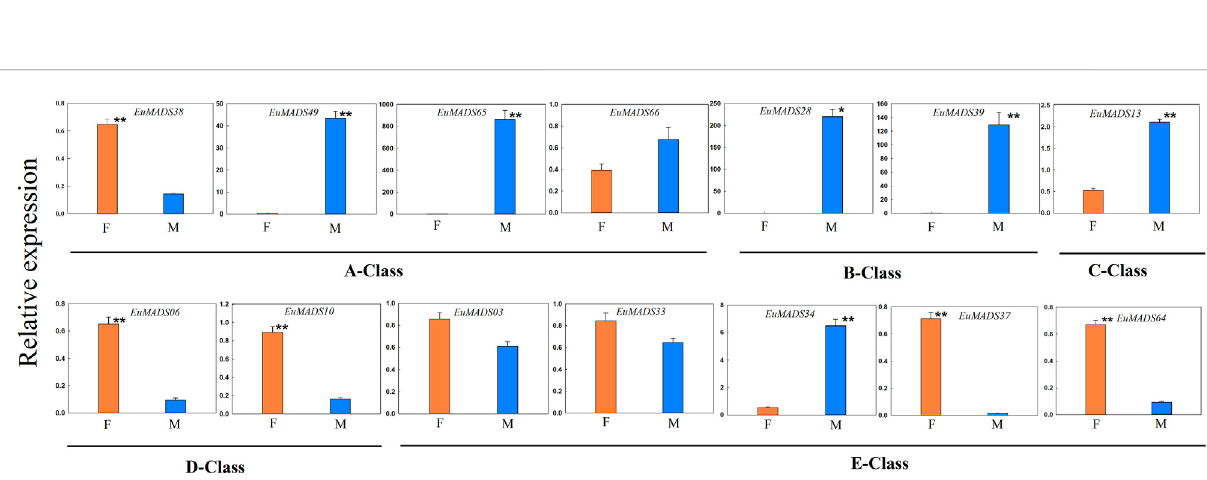
FIGURE 9 Quantitative real-time PCR (qRT-PCR) analyses of A/B/C/D/E-class EuMADS transcription factors in female (F) and male (M) fl owers of Eucommia ulmoides . A-class genes ( EuMADS38 , EuMADS49 , EuMADS65 and EuMADS66 ), B-class genes ( EuMADS28 and EuMADS39 ), C-class gene ( EuMADS13 ), D-class genes ( EuMADS06 and EuMADS10 ) and E-class genes ( EuMADS03 , EuMADS33 , EuMADS34 , EuMADS37 and EuMADS64 ) are all underlined. The error barswerecalculated from fi vebiologicalreplicatesand two technical replicates. Signi fi cant differencesbetweensexes are indicated with *( p < 0.05) and **( p <